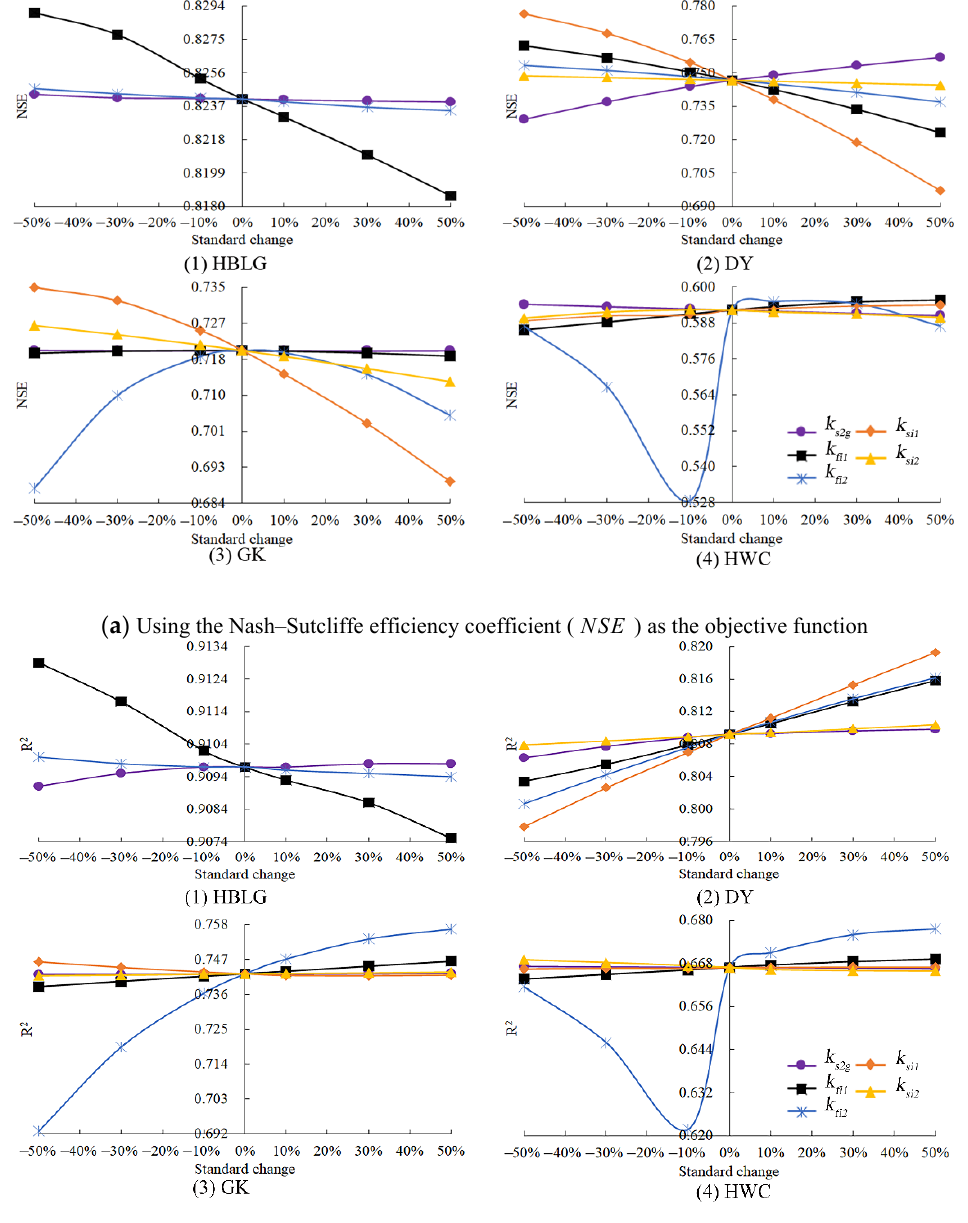
Figure 5. Standardized sensitivity curves of responding parameters of interflow. ( a ): Using the Nash–Sutcliffe efficiency coefficient ( NSE ) as the objective function; ( b ): Using the correlation coefficient ( R 2 ) as the objective function.